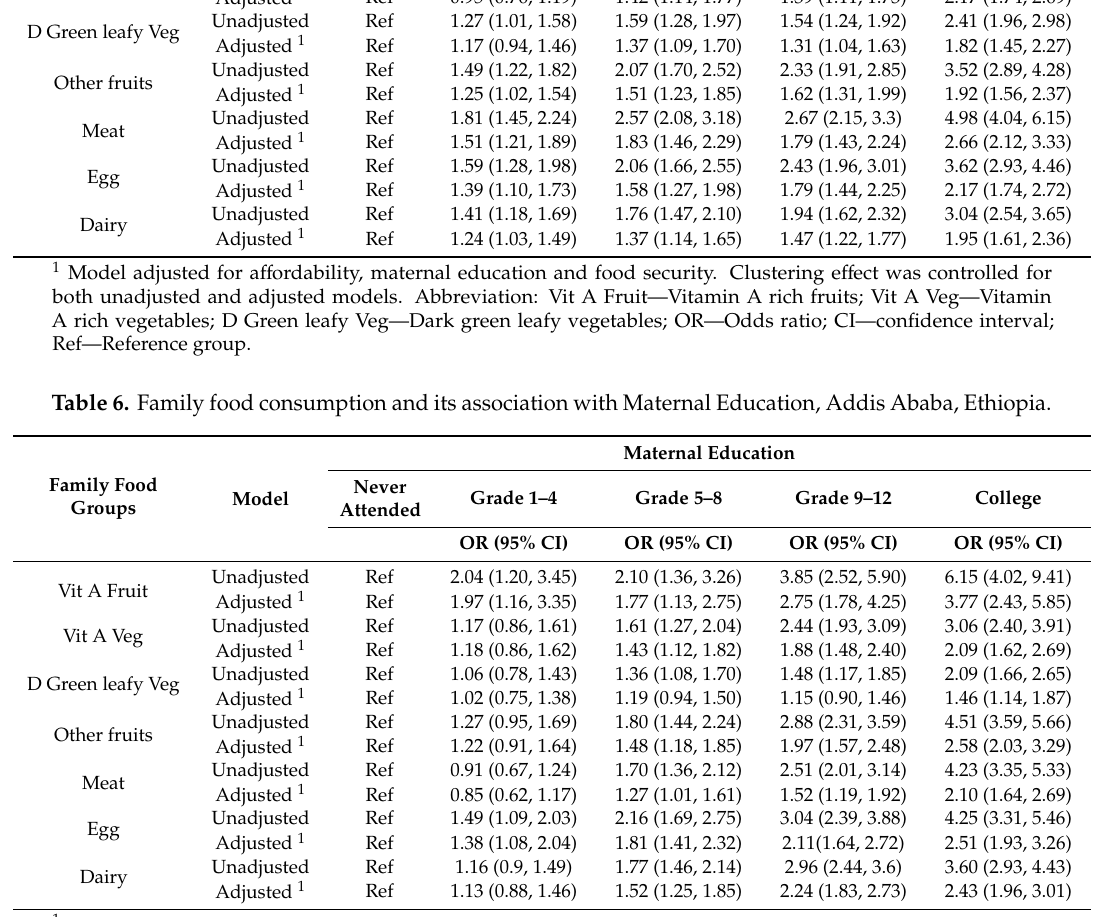
Family Food Groups